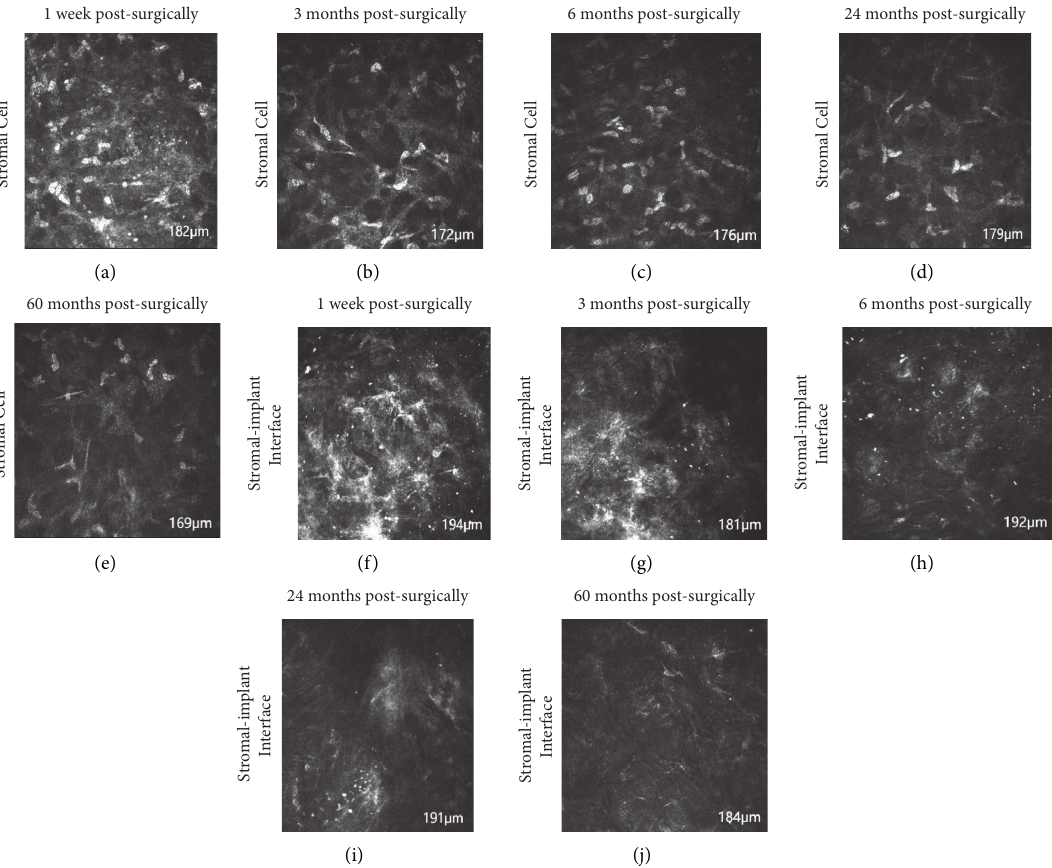
Figure 6: At 1 week postsurgically, there was edema, stromal cell activation at the corneal stroma (a). Lenticule-stroma interfaces are characterized by high reflectivity with bright dots (f). Edema, stromal cell activation and reflectivity gradually decreased over time (3 months postsurgically (b, g); 6 months postsurgically (c, h); 24 months postsurgically (d, i). At 60 months postsurgically, edema subsided and stromal cells remained stable (e), but high reflectivity still appeared in stromal-implant interfaces